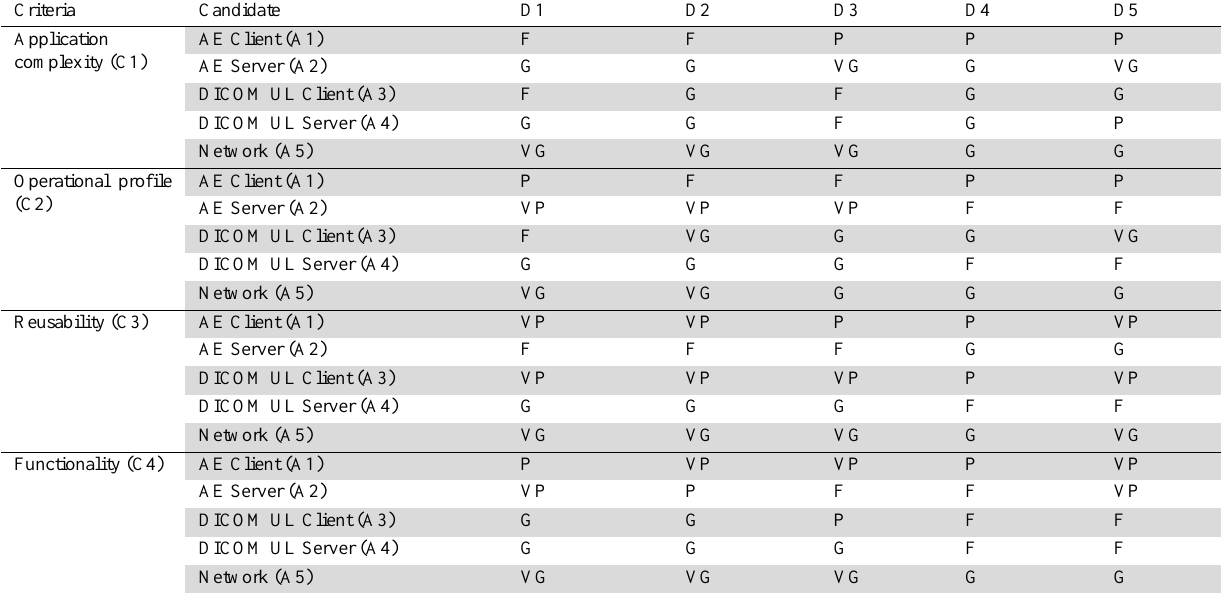
Reliability ranking assignment matrix for MIS Criteria